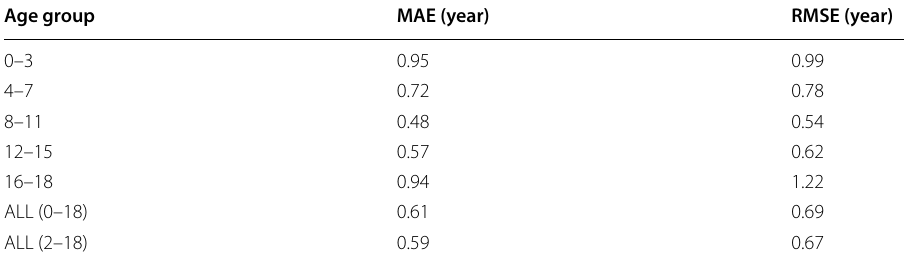
Table 2 Test result of the